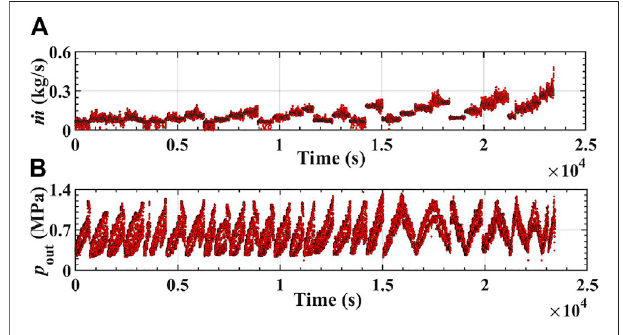
FIGURE 3 | Time-varying characteristics of the key operating